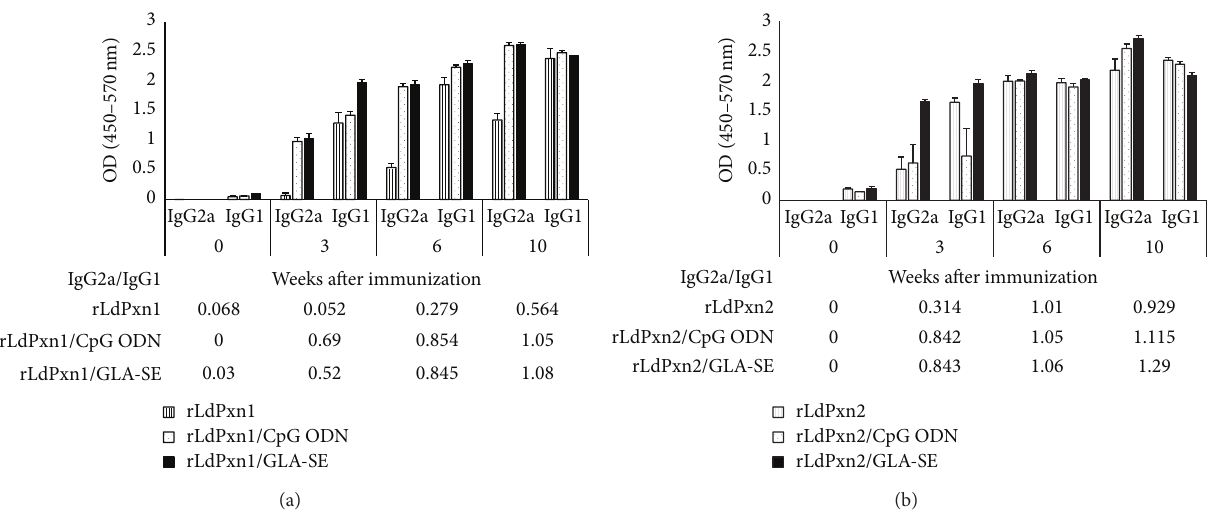
Figure 3: Anti-LdPxn1 and -LdPxn2 antibodies in immunized mice. Mice were immunized subcutaneously with recombinant LdPxn1 or LdPxn2 proteins with or without CpG ODN or GLA-SE. Mice were boosted twice in 3-week intervals. The levels of IgG1 and IgG2a isotypes were measured on sera collected at different time points using ELISA. Data are presented as the mean OD ± S.E.M. of IgG1 and IgG2a of sera from mice immunized with rLdPxn1 (a) and rLdPxn2 (b). The IgG2a/IgG1 ratios are shown in tables below each figure.